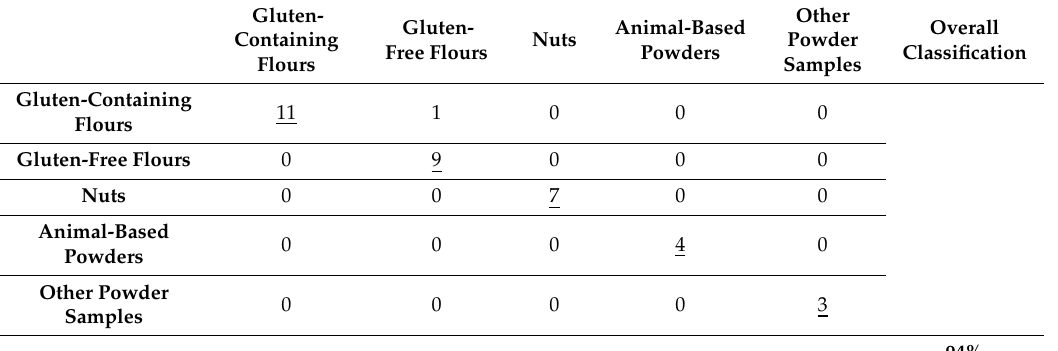
Table 5. Confusion matrix for classifying di ff erent tested materials in the Flour Group (FG) using the NIR sensor and K-nearest neighbour (KNN) classifier with standard normal variate (SNV) pre-processing.